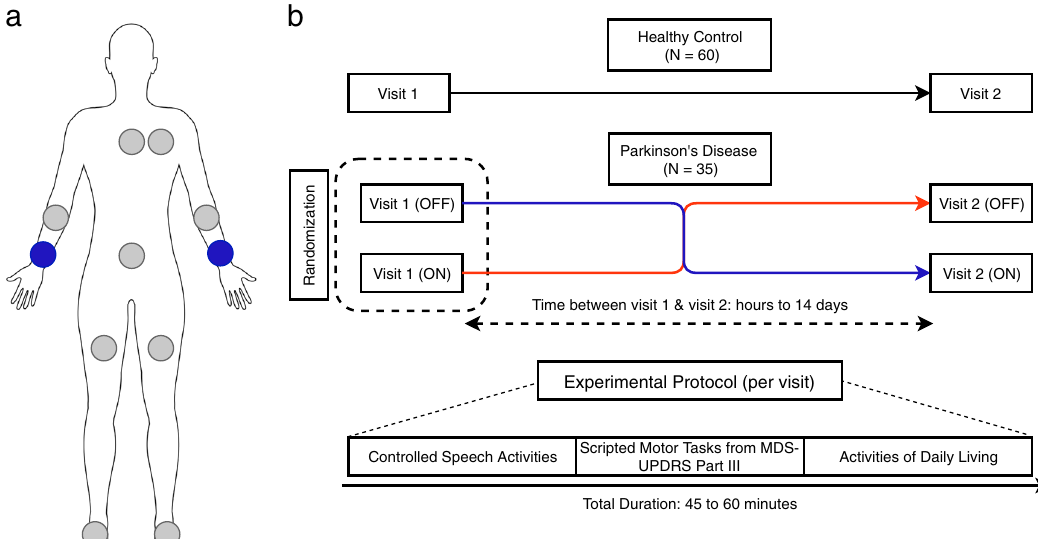
Fig. 8 Sensor setup and experimental protocol. a An illustration of the sensor setup used for data collection. Sensor data from only one device (blue) attached to the wrist of the most affected side (PD) or dominant side (HC) was used for the analysis presented in this paper. b Both the PD study and the HC study consisted of two in-clinic visits. Subjects performed a series of activities that were repeated in each visit. Activities were categorized into controlled speech activities, scripted MDS-UPDRS tasks, and activities of daily living. For HC ’ s both visits were identical whereas PD patients were randomly assigned to be in their self-reported ON or OFF motor state for a given visit.